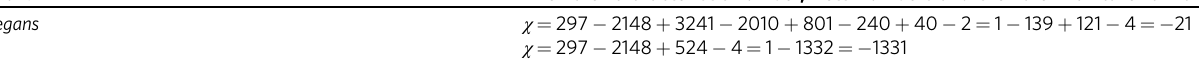
Table 3 Euler characteristic number, Betti numbers, and the Euler-Poincaré formula for the C. elegans network and the Erdös- Rényi (ER) network. Network The Euler characteristic number, Betti numbers and the Euler-Poincaré formula C.